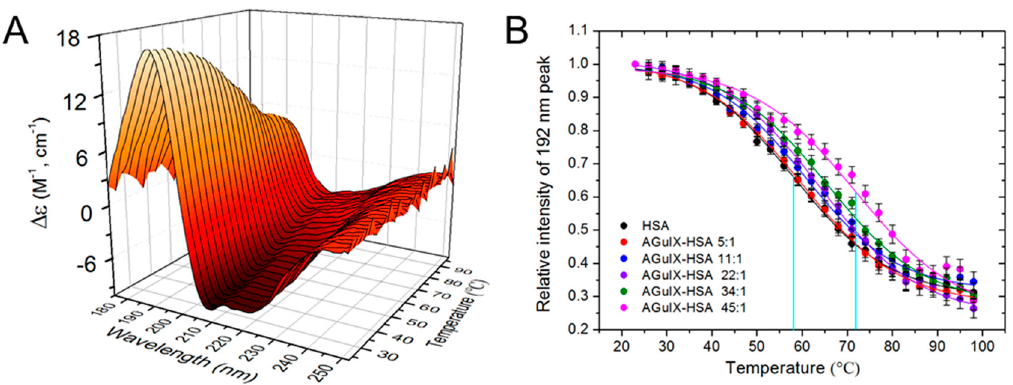
Figure 3. ( A ) SRCD spectra of HSA mixed with AGuIX ® (at a ratio of 22:1) recorded at di ff erent temperatures. ( B ) Thermal unfolding curves i.e., relative intensities of the peak at 192 nm for the pure HSA and HSA in the presence of AGuIX ® at di ff erent concentrations as a function of the temperature. The melting temperatures correspond to the midpoint of the respective curves (cyan vertical lines).